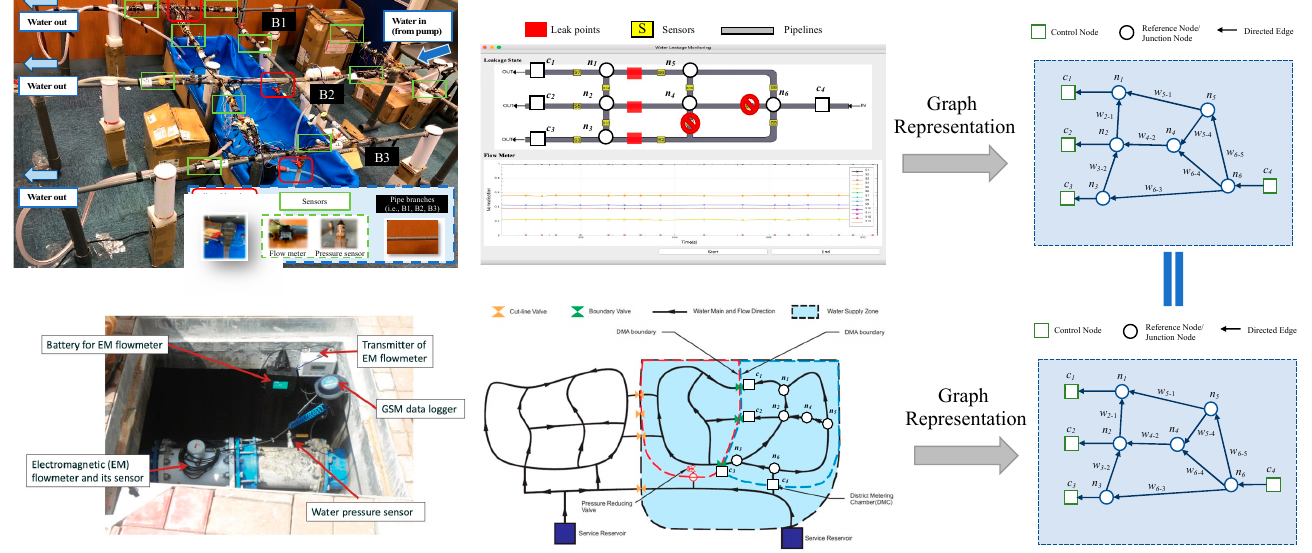
Figure 3. The experimental setup for multi-leakage detection.